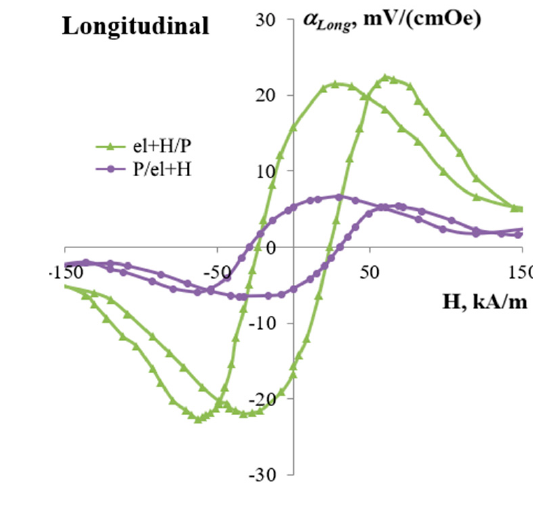
Figure 3. Linear magnetoelectric effect in samples coated with nickel with a thickness of 50 µ m on each side, obtained in a magnetic field: ( a ) for transverse orientation; ( b ) for longitudinal orientation. For a film obtained by deposition without a magnetic field on pre-polarized ceramics, a study of the temperature dependence of specific magnetization, magnetic susceptibility, and crystal structure was carried out (Figure